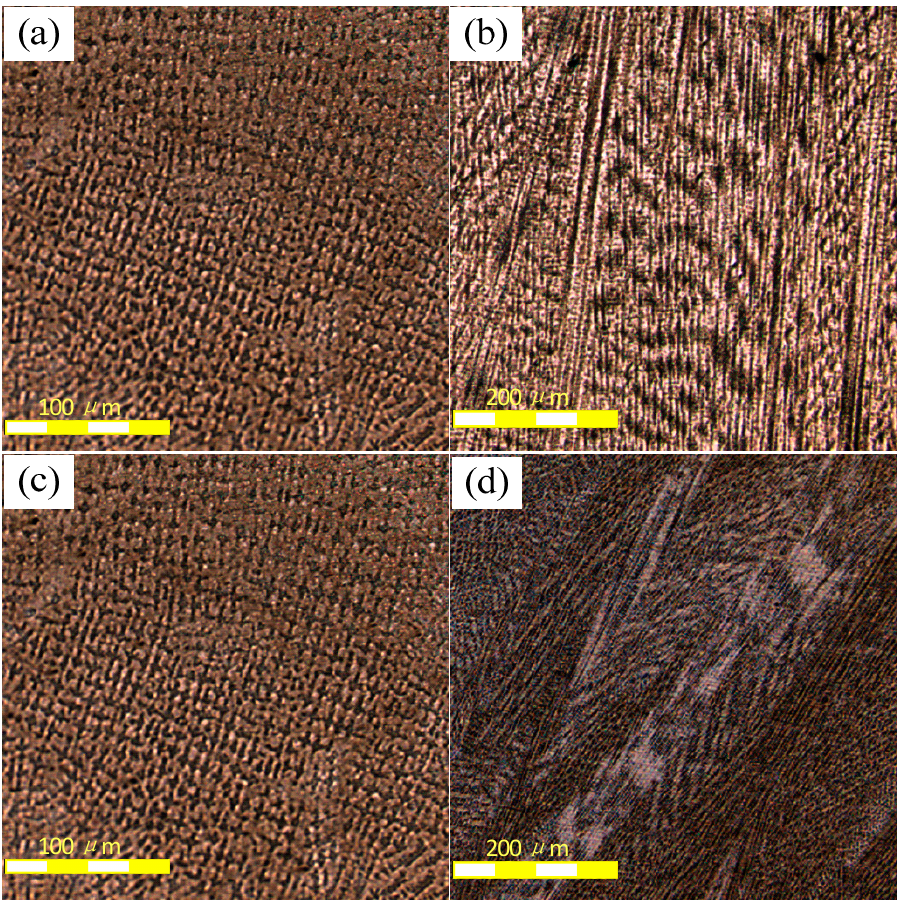
Figure 5. Microstructures of No.1 and No.2 alloy: ( a ) equiaxed dendrite in No.1 alloy; ( b ) columnar dendrite in No.1 alloy; ( c ) equiaxed dendrite in No.2 alloy; ( d ) columnar dendrite in No.2 alloy.